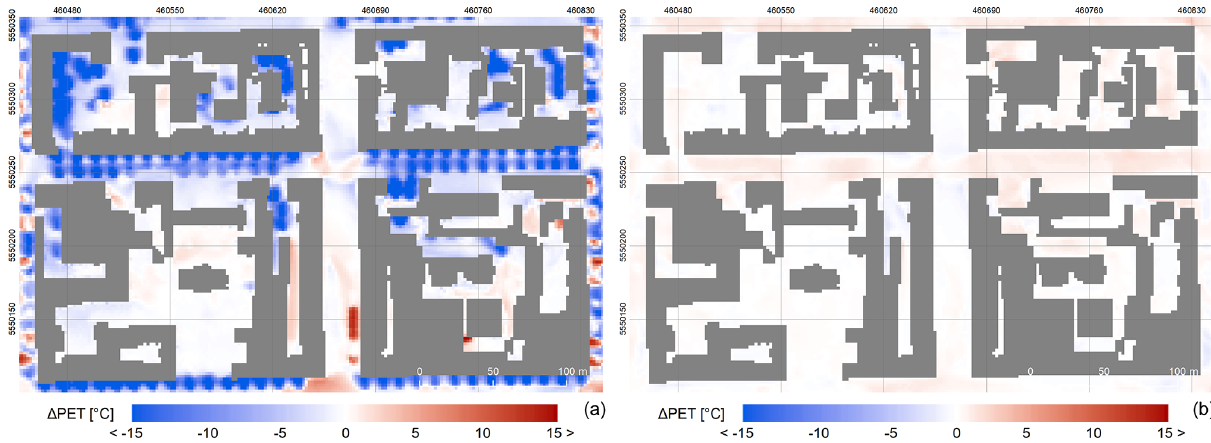
Figure 10. Example of spatio-temporal variability of 3h PET differences for green-city scenario SB12 at 09:00–12:00UTC (a) and 21:00– 24:00UTC (b) . Projection: WGS 84 / UTM zone 33N; layer with roofs is own data source.